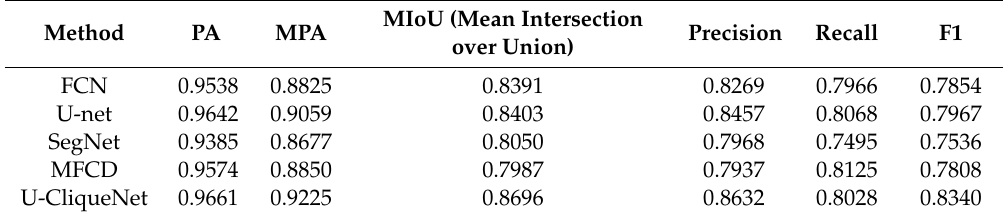
Table 4. Performance of these five algorithms: the fully convolutional networks (FCN), U-net, Encoder–decoder network (SegNet), the multi-scale fusion crack detection (MFCD) algorithm and the proposed U-CliqueNet.